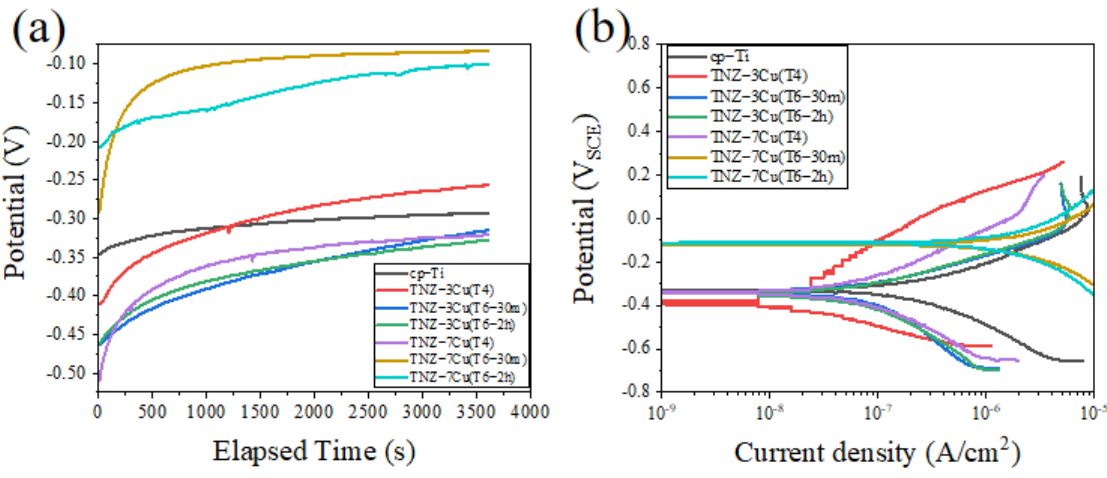
Figure 8. OCP curves and Tafel curves of TNZ-xCu(wt.%, x = 3, 7) and cp-Ti; ( a ) OCP; ( b ) Tafel. Table 2. Electrochemical parameters of TNZ-xCu (wt.%, x = 3, 7) alloys and cp-Ti. Samples